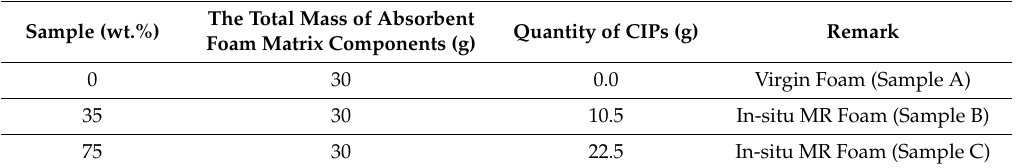
Table 2. Composition of MR foam.